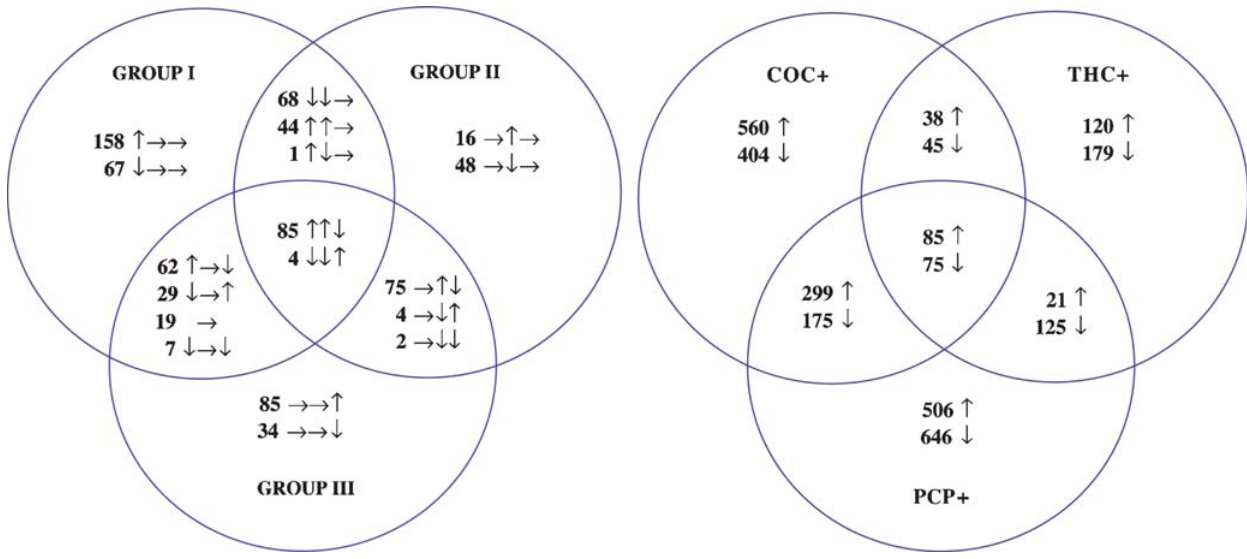
Figure 2. Venn Diagrams illustrating the distribution of significantly altered transcripts in groups defined by global expression profiles (A) or by drugs of abuse (B) . A. Eighty-nine transcripts were regulated in all three groups defined by global expression profiles. All of these were regulated in the same direction (increased or decreased) for Group I (DA1–18) and Group II (DA19–34), and in the opposite direction for Group III (DA35–42) cases. In all, 201/202 transcripts shared between Group I and Group II were regulated in the same direction. For Group III, 91/115 transcripts shared with Group I and 79/81 transcripts shared with Group II were regulated in the opposite direction. These data highlight the similarities of Group I and Group II, and the marked differences in Group III cases. Each cluster of three arrows indicates the direction of change in Groups I, II and III, respectively. Increased expression is indicated by q , a decrease by Q , while R indicates no significant change. B. Cases with a drug abuse history and positive cocaine, phencyclidine or cannabinoid toxicology in blood, brain or urine were grouped into COC + , PCP + and THC + groups, respectively. While there were significant transcriptional differences between these groups, a total of 160 transcripts ( < 2% of all transcripts) were shared for the three groups. Note that a much smaller number of transcripts were identified for the THC + group (264 increased, 424 decreased) than for the COC + (982 increased, 699 decreased) and PCP + (911 increased, 1021 decreased) groups. Increased expression is indicated by q , decreased expression by Q .